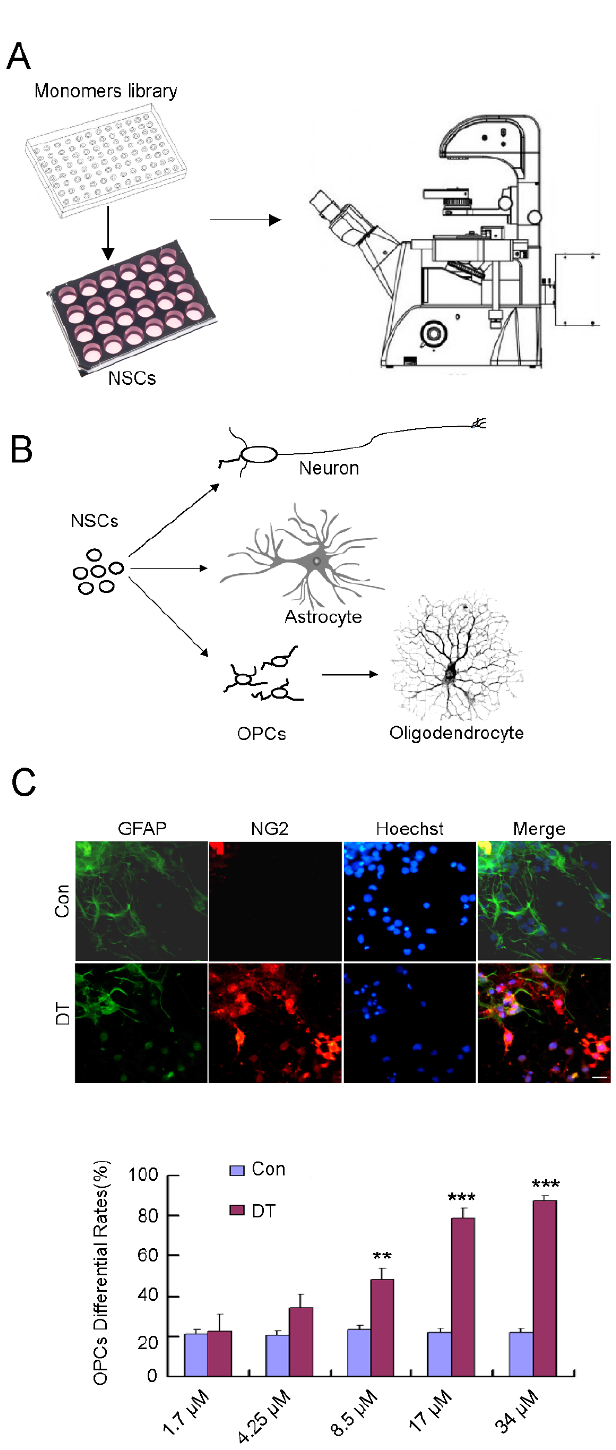
Figure 1. ( A ) DT promotes the generation of OPCs from NSCs. Scheme of Chinese herb monomer library screening in NSC culture. Scheme of NSCs differentiation. ( B ) NSCs differentiate into three types of cells with distinct morphology: neurons, astrocytes and OLs. ( C ) NSCs treated with or without DT had different OPC differentiation rate. Cells were immunostained for NG2 (red) or GFAP (green), and Hoechst (blue) was used to label cell nuclei. DT treatment dramatically increased the generation of NG2-positive cells. The ratio of NG2-positive cells derived from NSCs was determined after cultures were treated with DT at different concentrations. **, p < 0.01, ***, p < 0.001 by Student’s t -test.